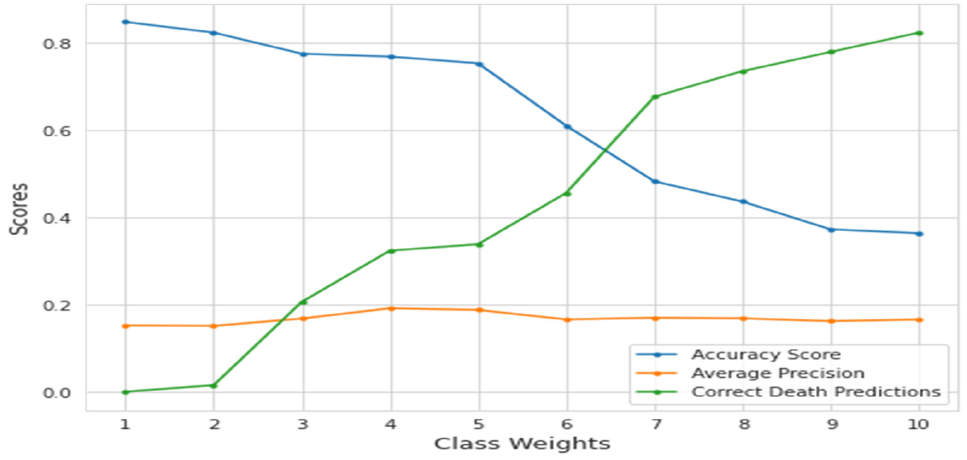
Figure 3. Summary of the precision–recall curve.